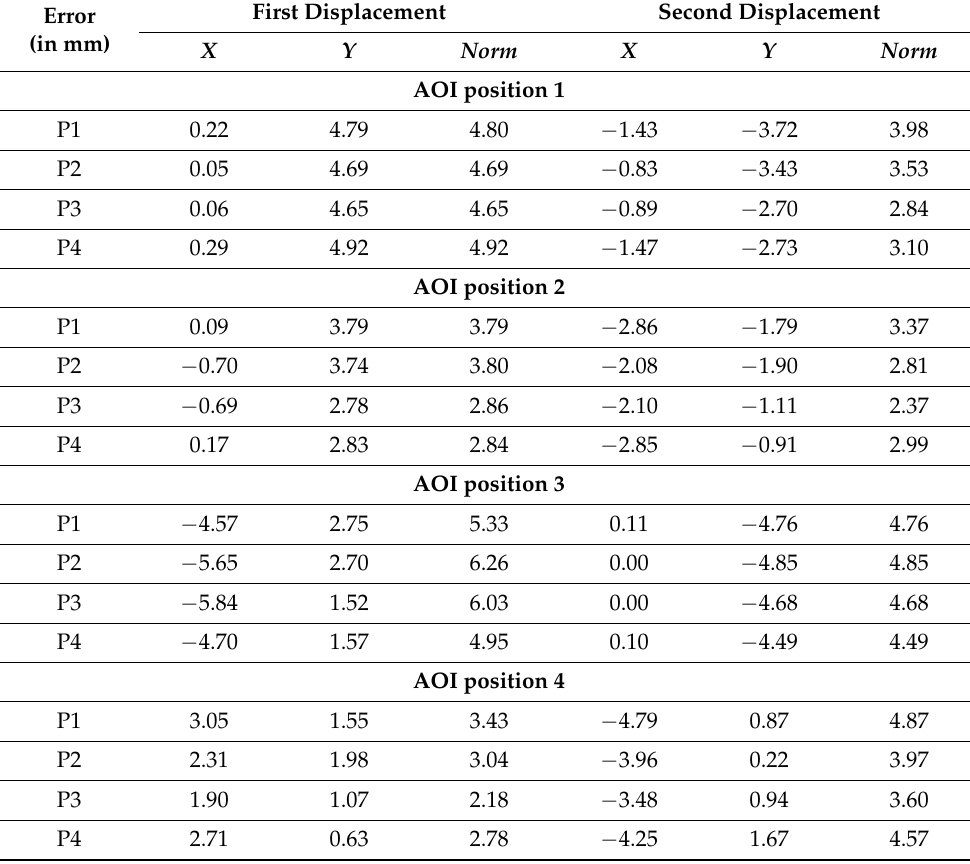
Figure 21. Distance error between test 1 and test 2.